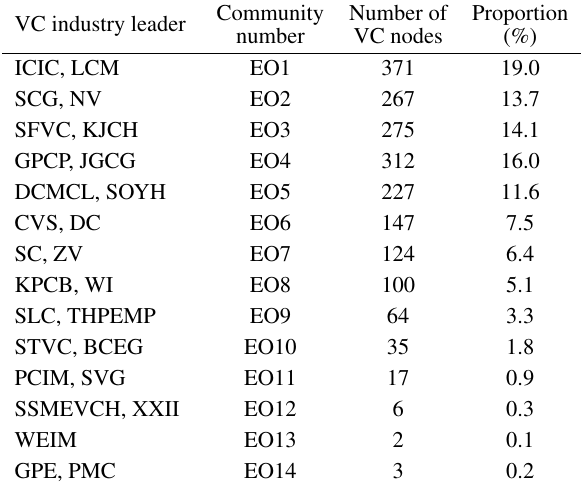
Table 5 EO community detection results.